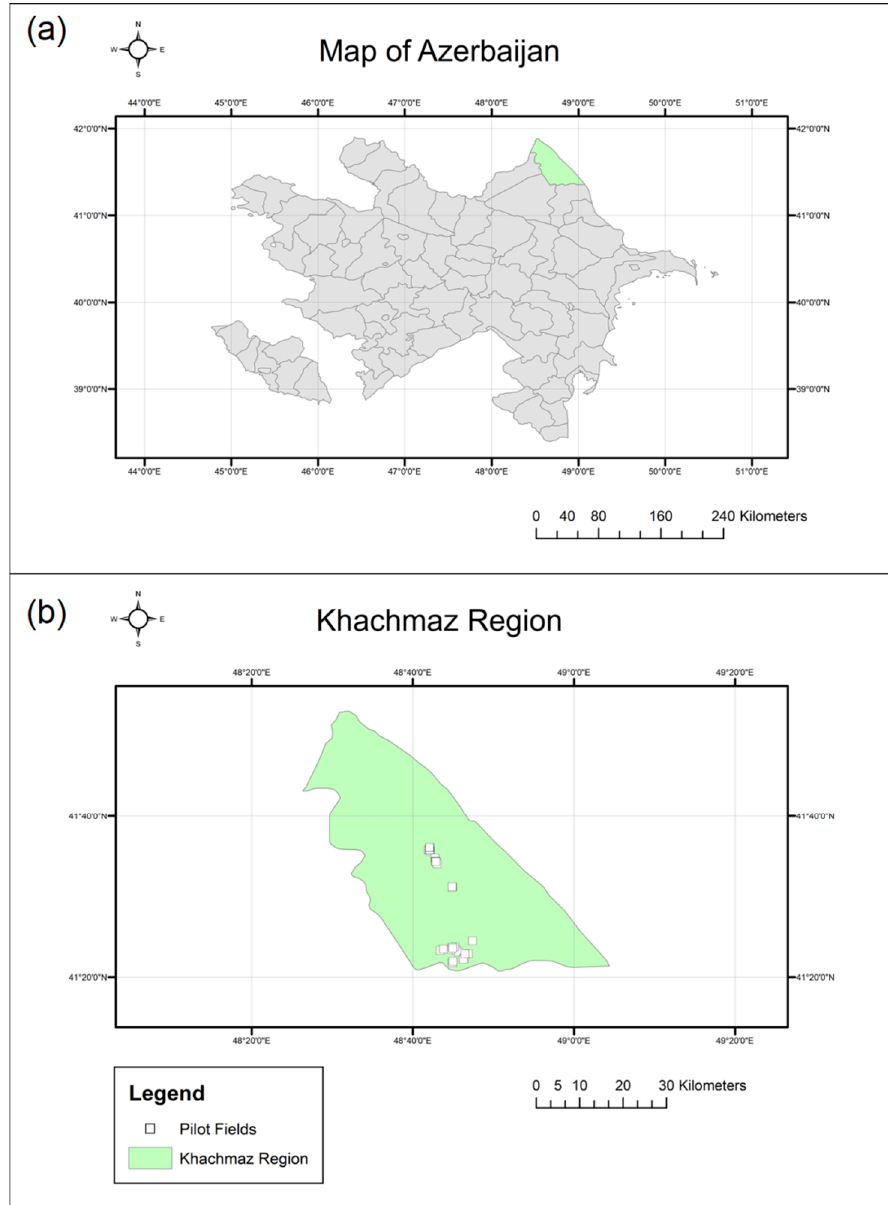
Figure 1. The study area: ( a ) map of Azerbaijan and the location of the study area; ( b ) the distribution of the study fields in the study area.